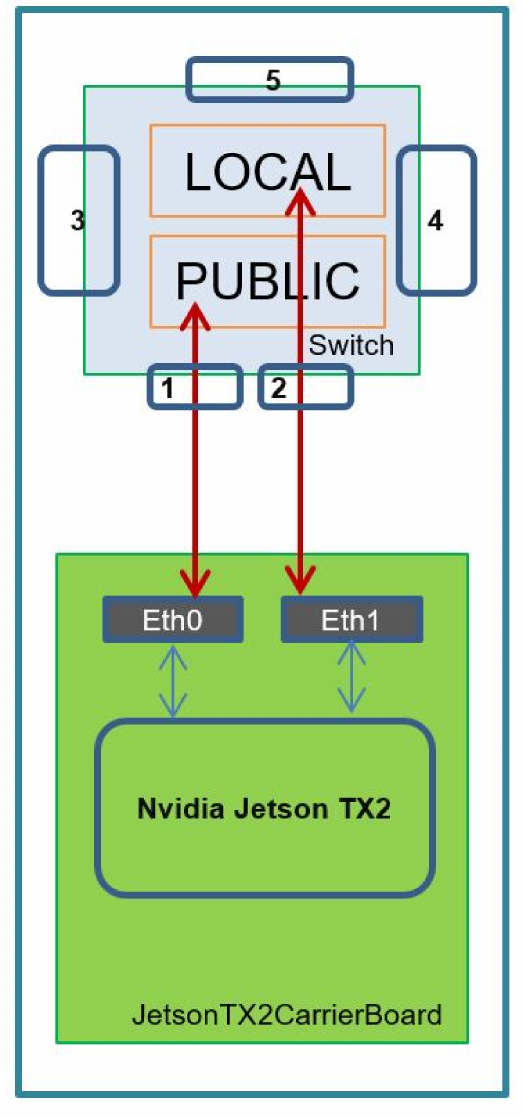
Figure 11. VVSP module